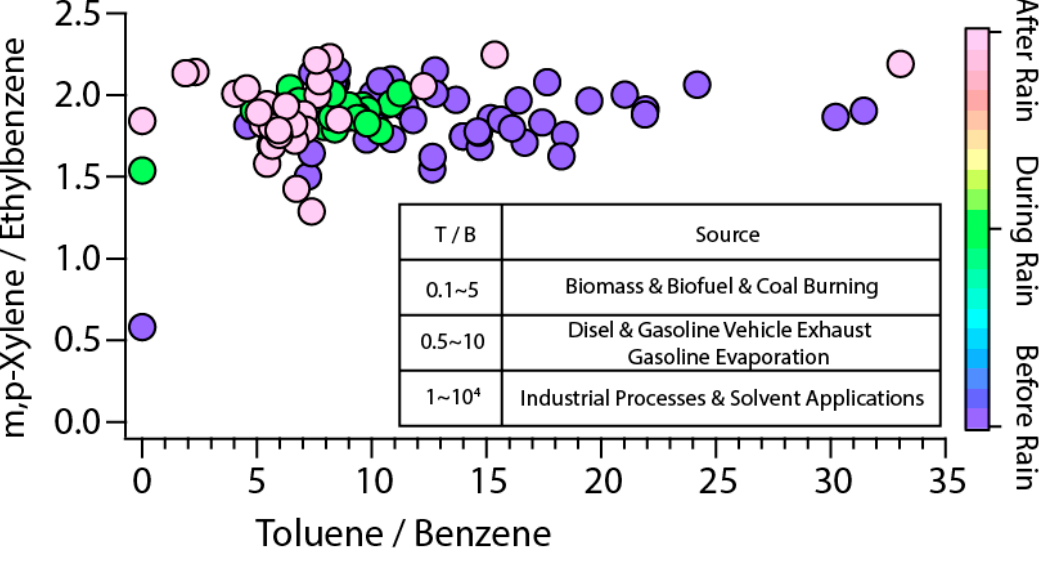
Figure 6. VOCs cross-plots for the ratio of toluene vs. benzene and m,p-xylene vs. ethylbenzene. The T/B of this study ranged from 1.89 to 33.05, with an average of 10.05, and 101